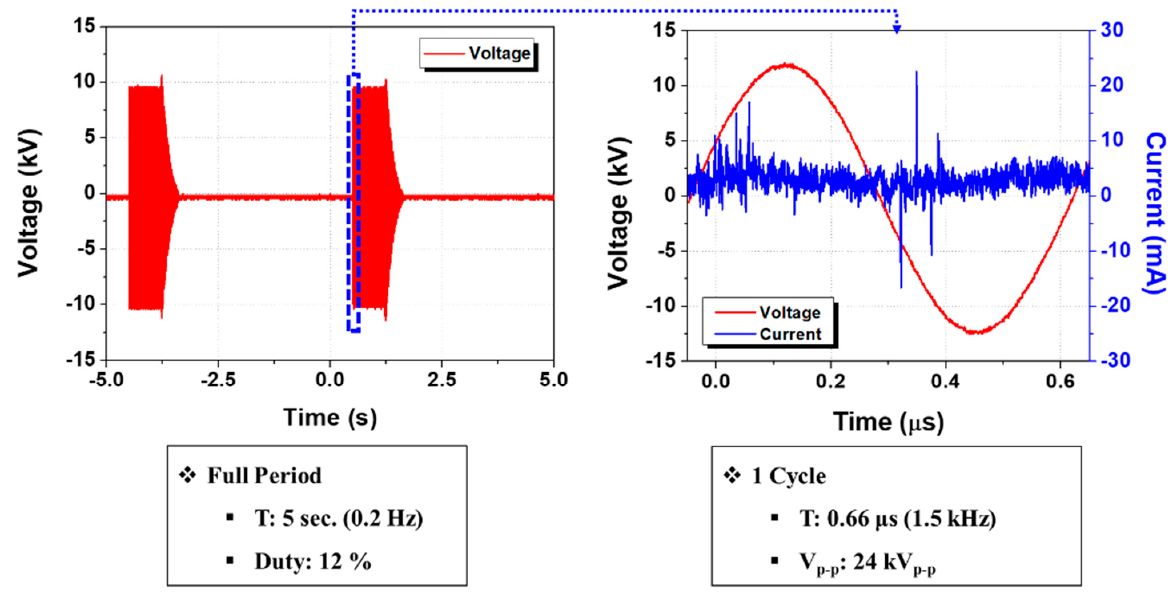
Figure 3. Applied sinusoidal waveform which has 24 kV p-p and 1.5 kHz was tripped by trip signal which has 0.2 Hz and 12% duty.